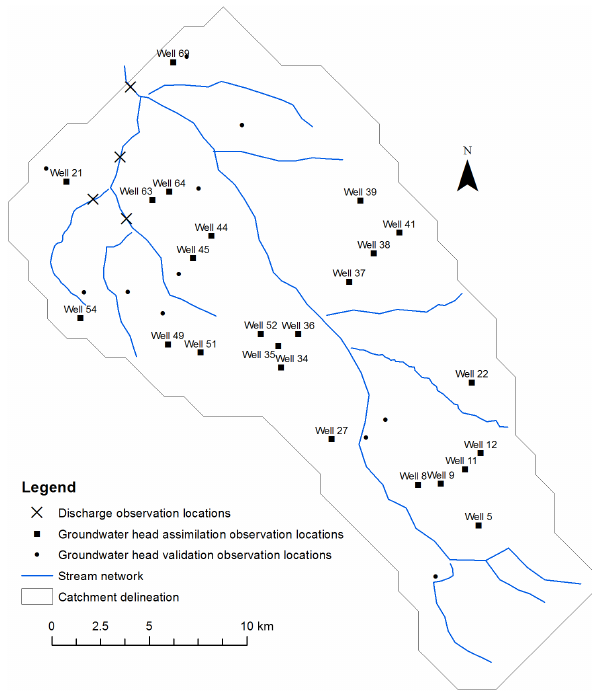
Figure 1. The Karup catchment with locations of discharge and hy- draulic head